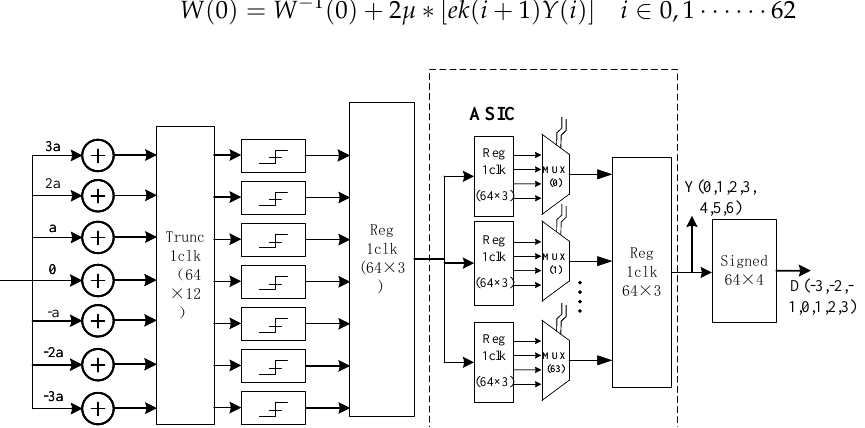
Figure 7. 1-tap pre-judgment DFE.